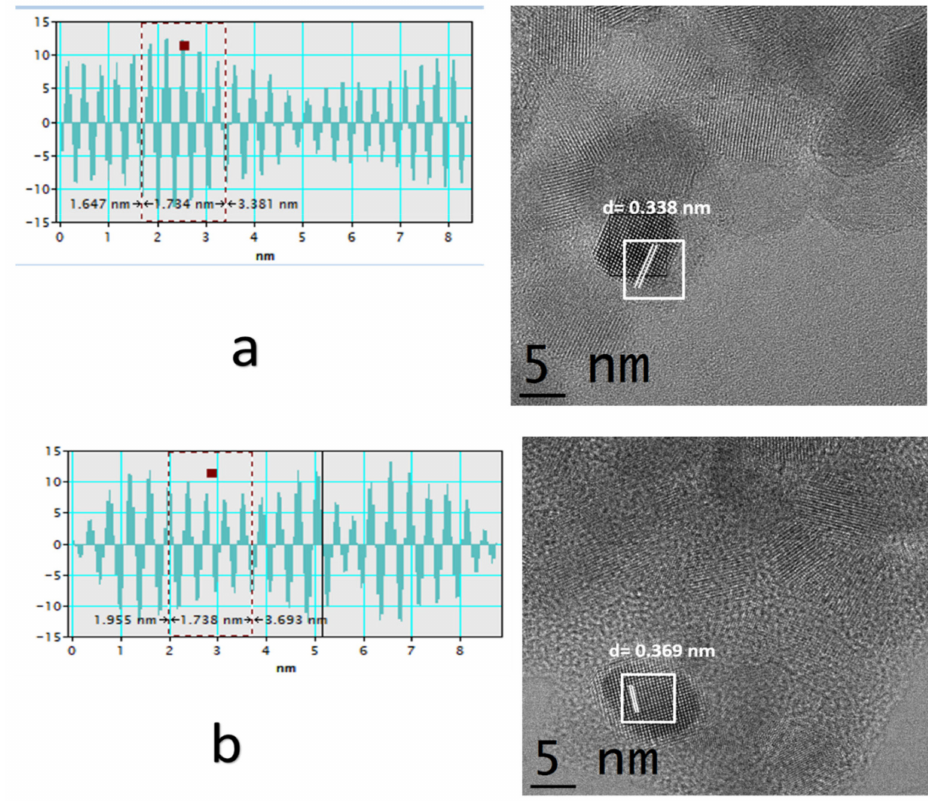
Figure 7. HRTEM images for TZr-1 ( a ) and TZr-10 ( b